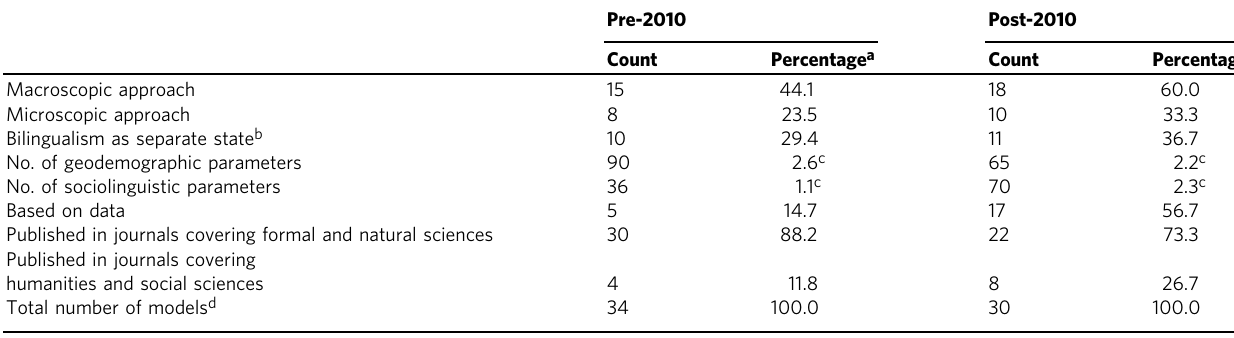
Table 5 Comparison of models characteristics during the periods pre-2010 and